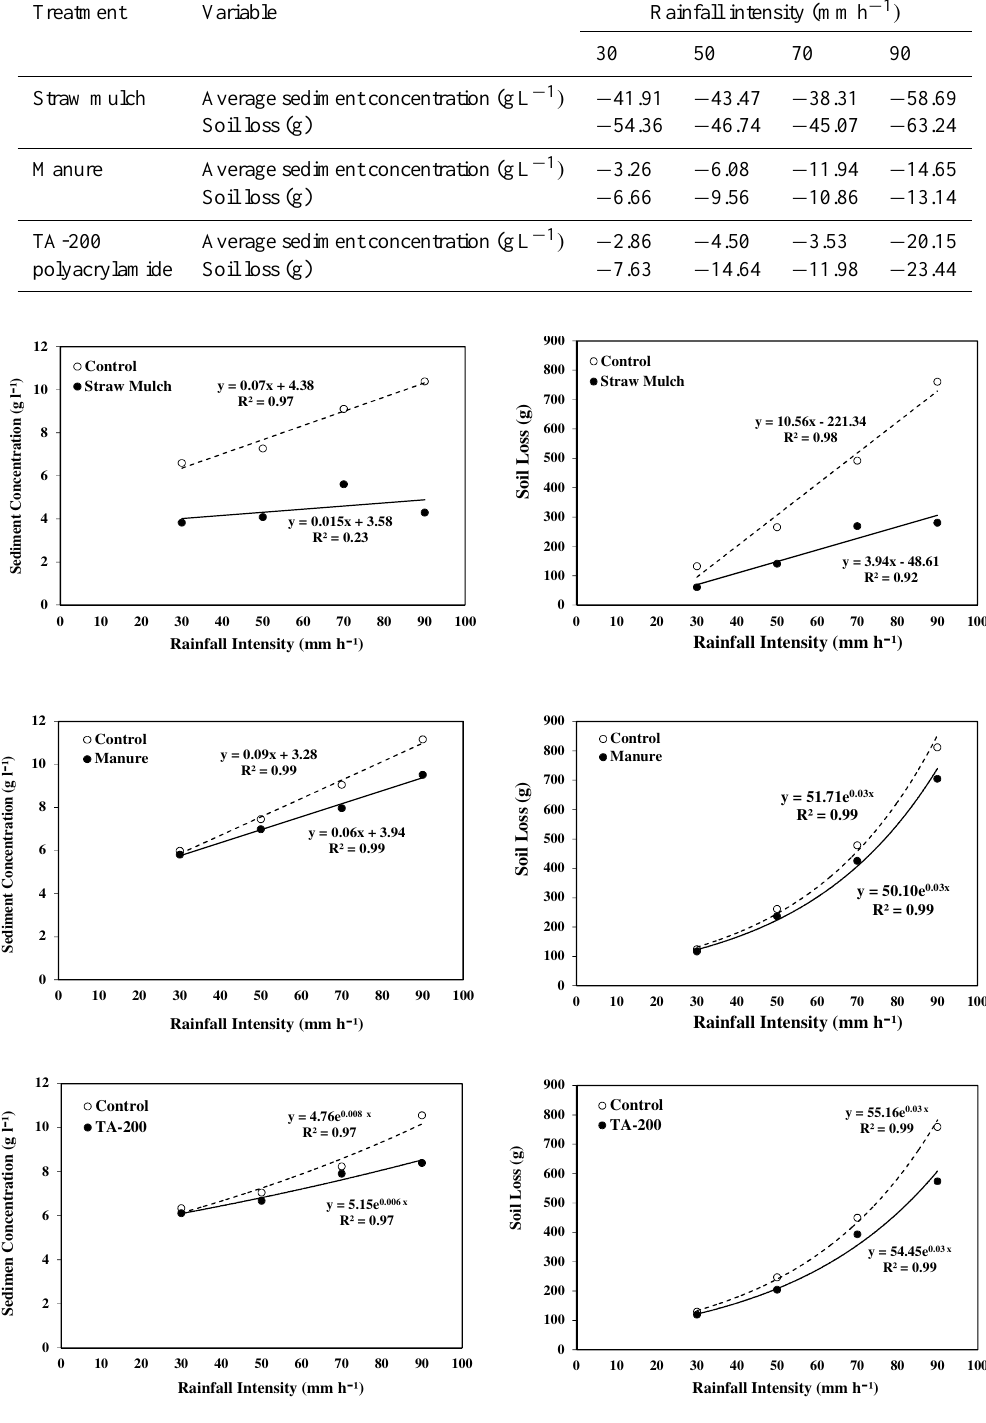
Figure 2. Relationships between rainfall intensity and organic and inorganic treatments on average sediment concentration (left column), soil loss (right column), rice straw mulch (top), manure (middle) and T-A 200 polyacrylamide (bottom).